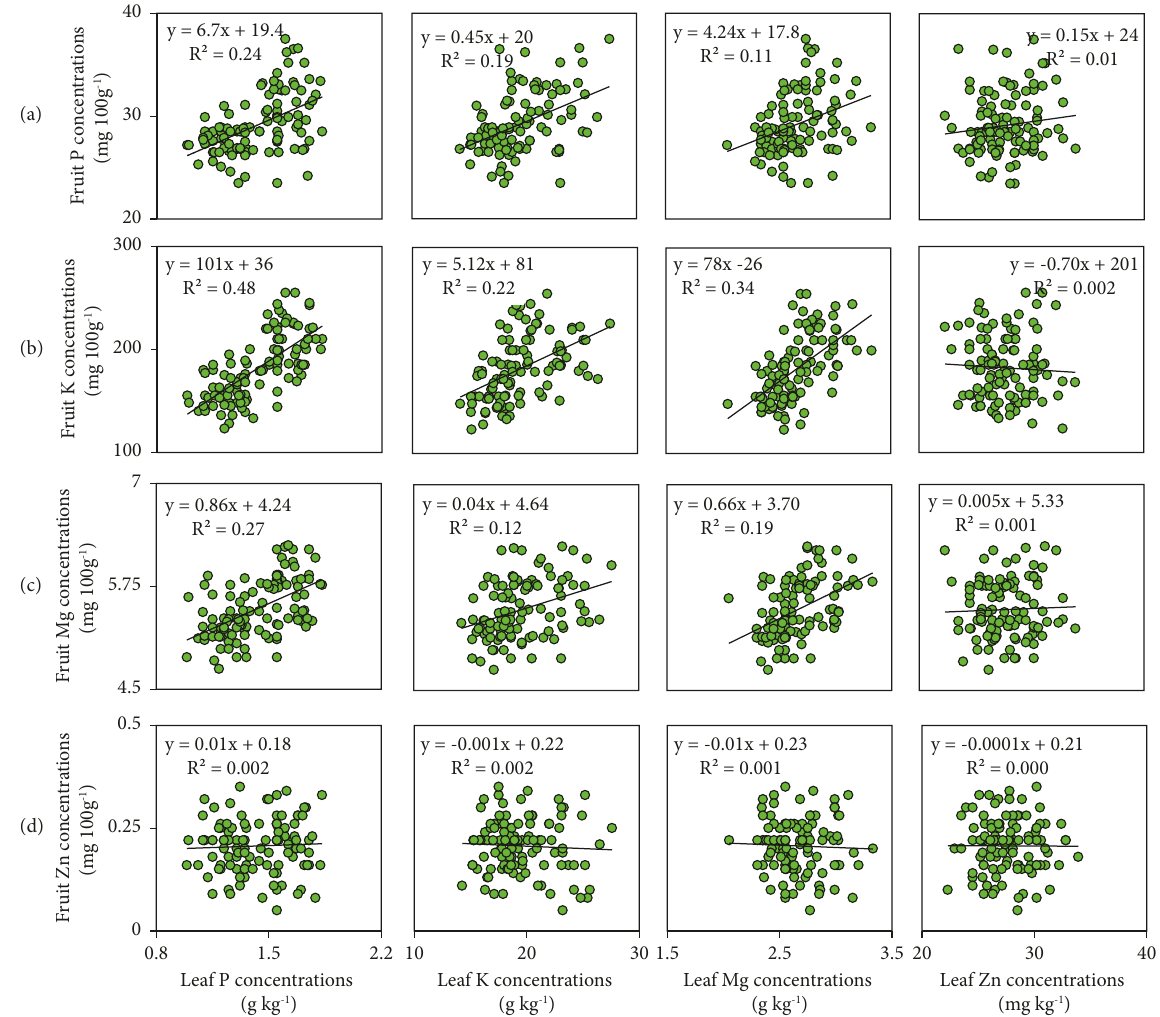
Figure 4: Linear correlation coefficient of pairs between fruit and leaf